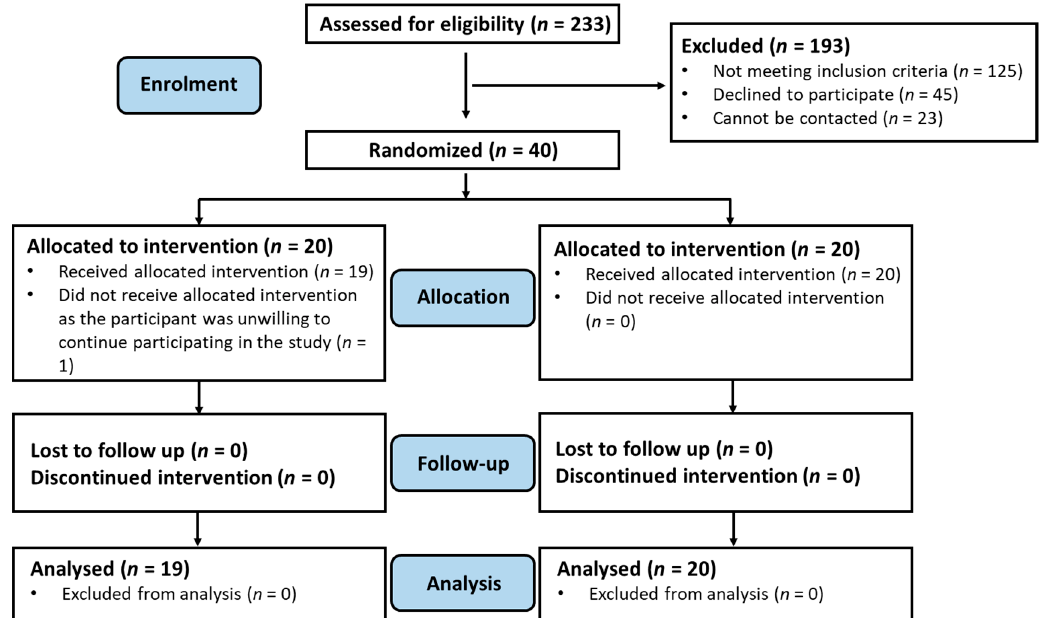
Figure 1. The Consolidated Standards of Reporting Trials (CONSORT) diagram showing the flow of the study.